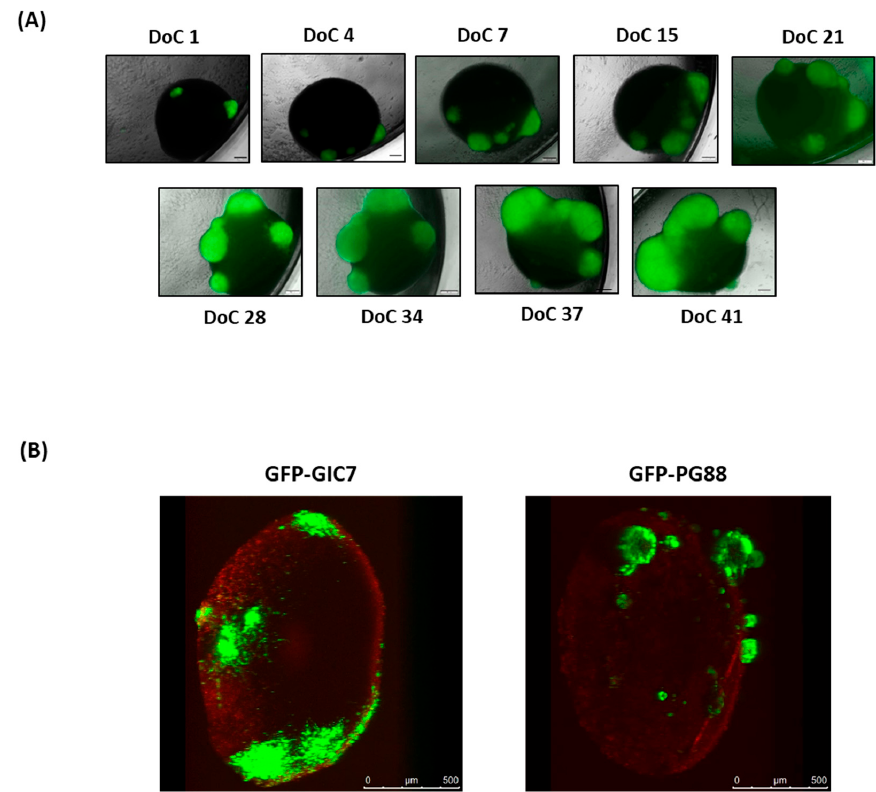
Figure 3. Follow-up of organoid-GICs co-culture by microscope . ( A ) Co-culture of GFP-GIC7 seeded as tumorspheres on top of the cerebral organoid, followed by fluorescence microscopy. Images were obtained from 1 to 41 days of co-culture (DoC) with a Microscopy Olympus IX51 at 4× magnification. Scale bar 200 µm. ( B ) Brain organoids were engrafted with 2000 single GFP-GICs proneural (left) and 2000 single GFP-mesenchymal (right) 24 days after seeding cells, which had already been differentiating for 47 days. Images were obtained with the confocal microscope. Scale bar 500 µm.